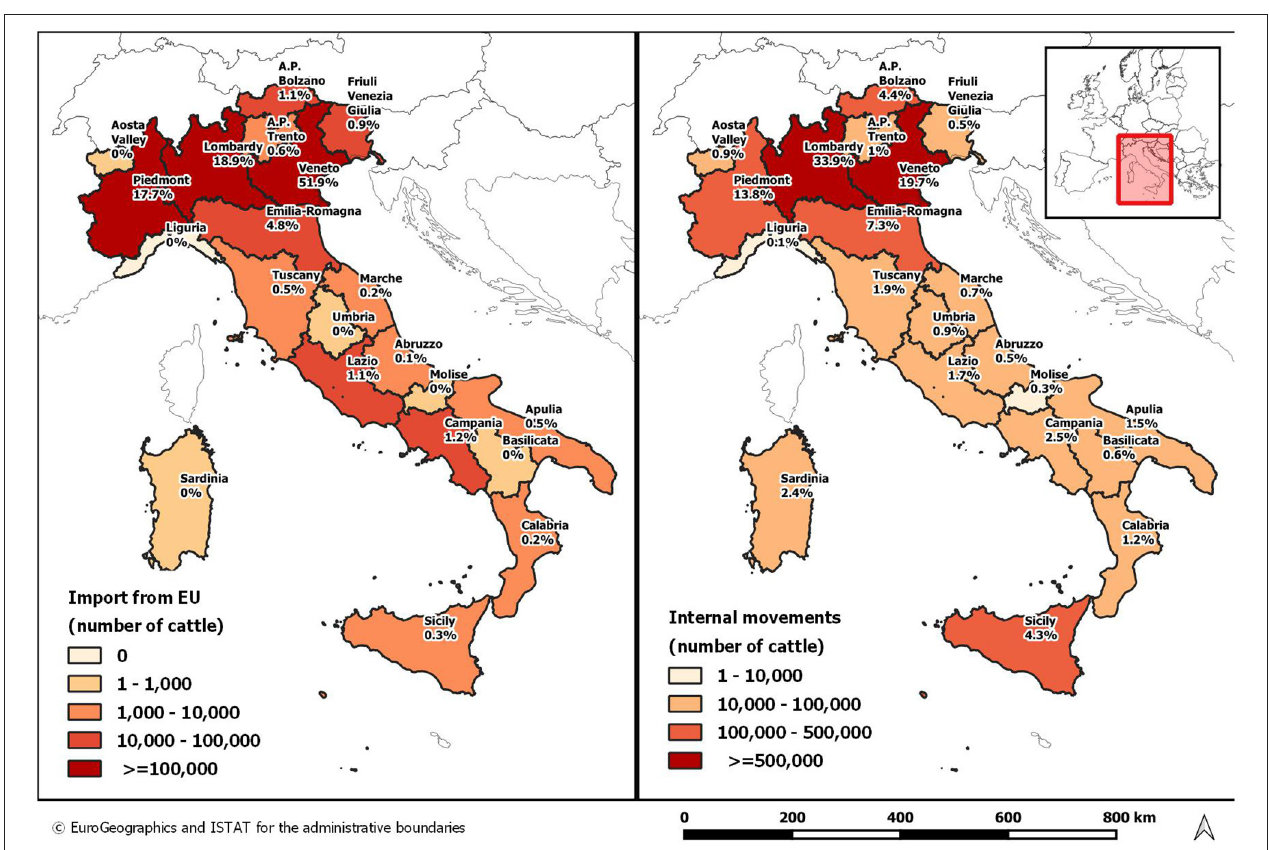
FIGURE 3 | Distribution of import and internal cattle movements, by region of destination, Italy 2019.